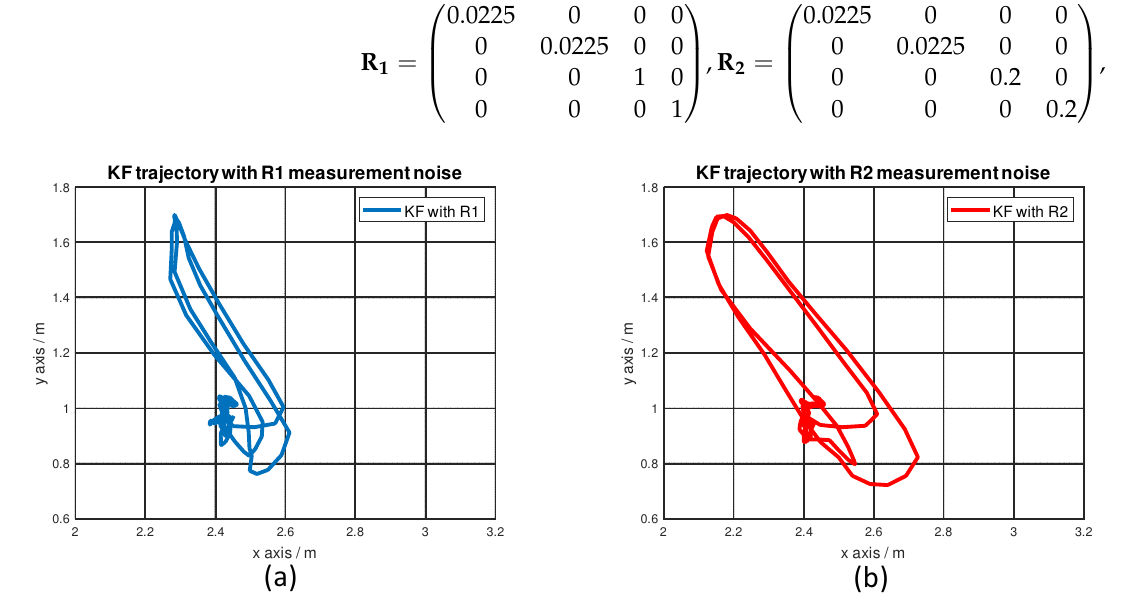
Figure 10. KF trajectory comparison: ( a ) R 1 measurement noise covariance matrix; ( b ) R 2 measure- ment noise covariance